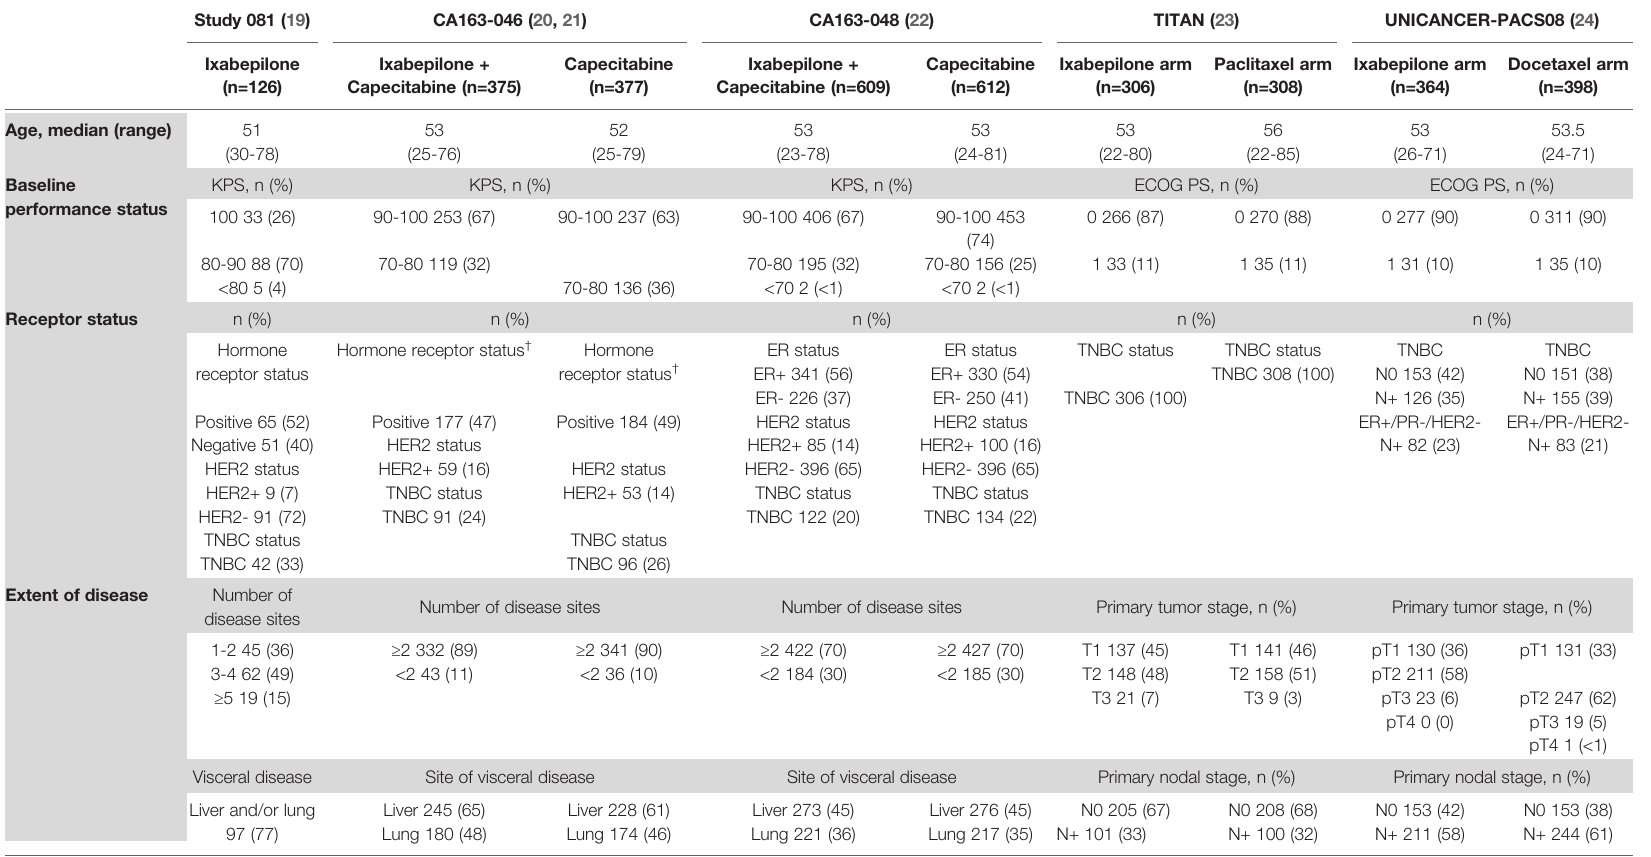
TABLE 1 | Baseline characteristics across clinical